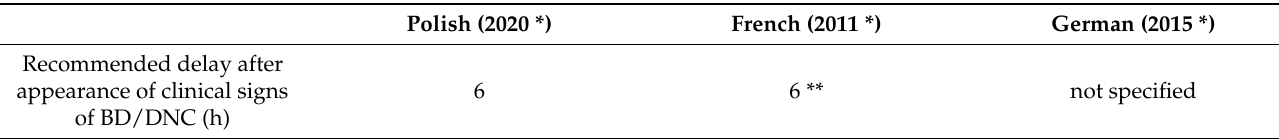
Table 1. Comparison of three frequently used European national guidelines for determination CCA with CTA during BD/DNC diagnosis